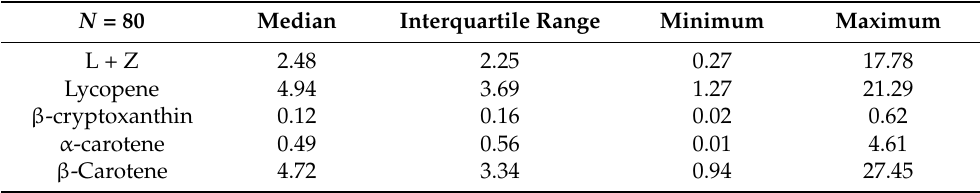
Table 3. Maternal dietary intake of carotenoids (mg/day).